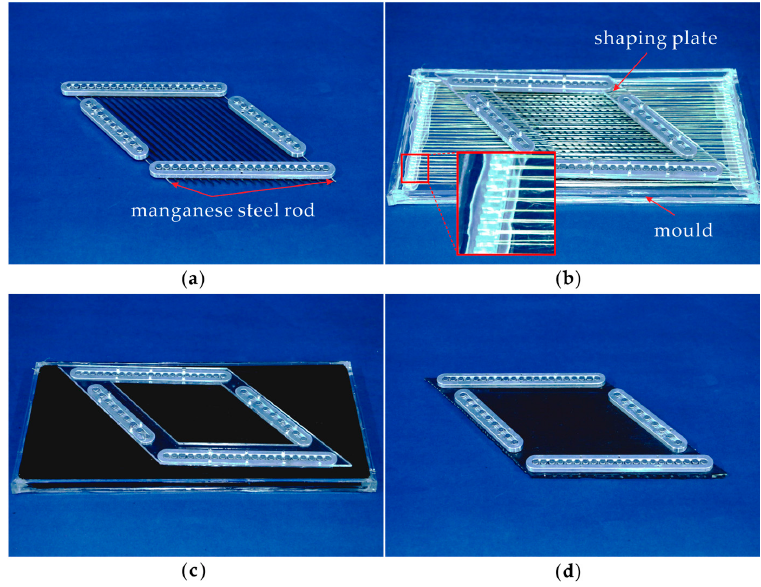
Figure 2. Fabrication procedure of the morphing wing skin specimen: ( a ) skeleton made of CFRP rods, manganese steel rods, and the frame; ( b ) mounting KFRP and shaping the initial angle of the specimen; ( c ) injecting rubber and curing; ( d ) removing the mold, pruning and obtaining the speci- men.